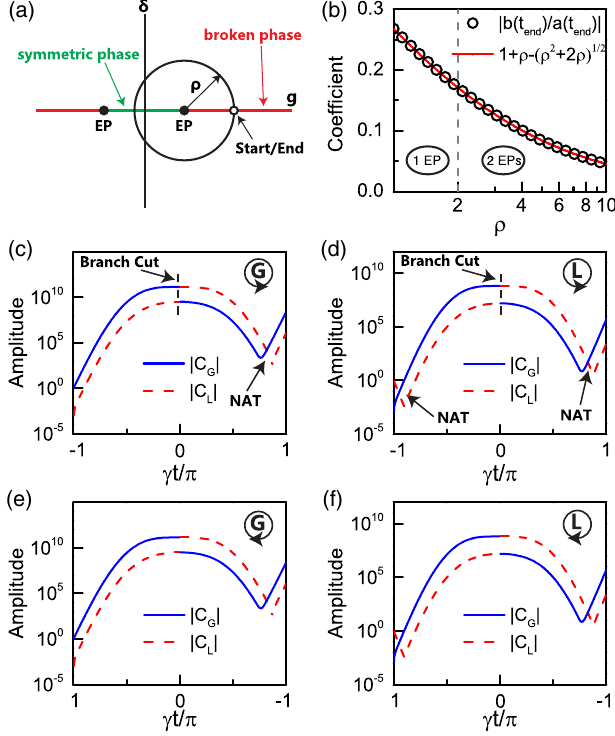
FIG. 11. (a) The g − δ parameter space where a pair of EPs locates at g ¼ (cid:2) 1 and δ ¼ 0 . The circle with a radius ρ depicts a trajectory to encircle the EP with the starting point in the broken phase. The red line and green line denote the broken phase and symmetric phase, respectively. (b) Calculated j b ð t a function of ρ with γ ¼ 0 . 1 (counterclockwise loops) and − 0 . 1 (clockwise loops). The region with ρ < 2 corresponds to the dynamical encircling of one EP, whereas that with ρ > 2 corresponds to the encircling of two EPs. We performed four calculations (i.e., counterclockwise/clockwise loop with a gain/ loss input) and the results are all the same, as shown by the black circles. The red line shows the value of ρ þ 1 − function of ρ , which matches well with the black circles, indicating that the final state is always a gain state. (c) – (f) Calculated amplitudes of the eigenvectors for (c) counterclock- wise loop with a gain input, (d) counterclockwise loop with a loss input, (e) clockwise loop with a gain input, and (f) clockwise loop with a loss input. In the calculations, we choose ρ ¼ 1 and γ ¼ (cid:2) 0 . 1 , corresponding to the dynamical encircling of an